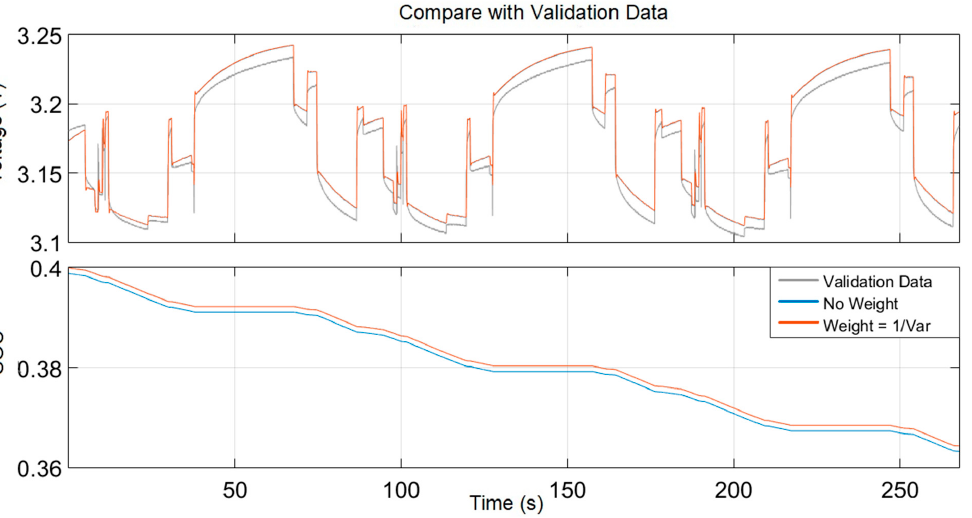
Figure 7. Comparison of the two-outputs nonlinear grey box model validation data with the best experiment.